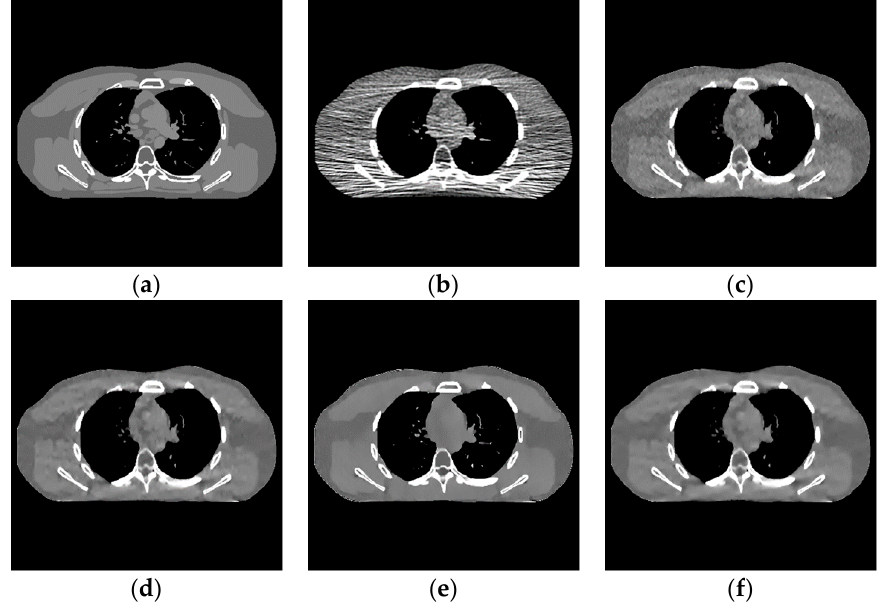
Figure 10. Experimental results of incident photon number 5 × 10 3 . ( a ) Real image; ( b ) FBP recon- struction; ( c ) EP iterative reconstruction image; ( d ) DCT image post-processing; ( e ) DL iterative reconstruction; ( f ) learning sparse transform.